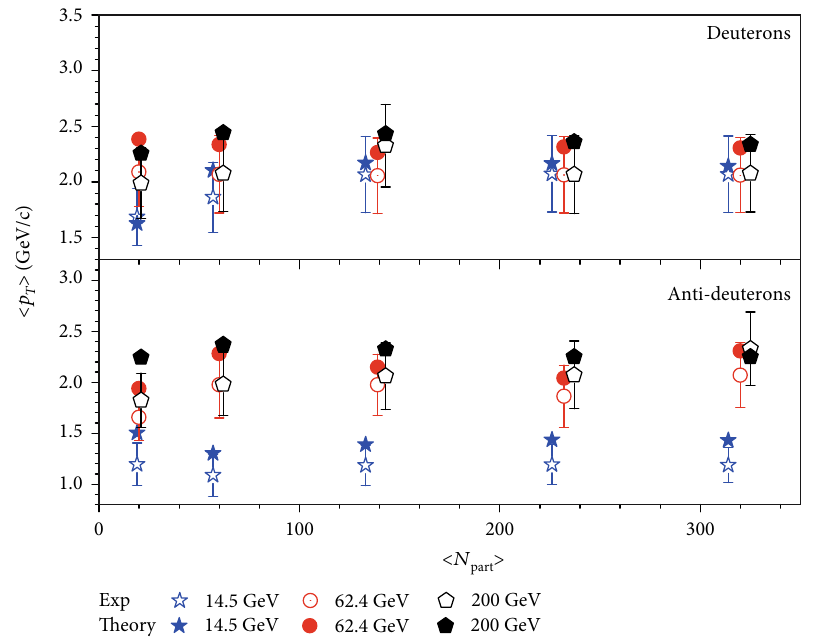
ffiffiffiffiffiffiffi p s NN